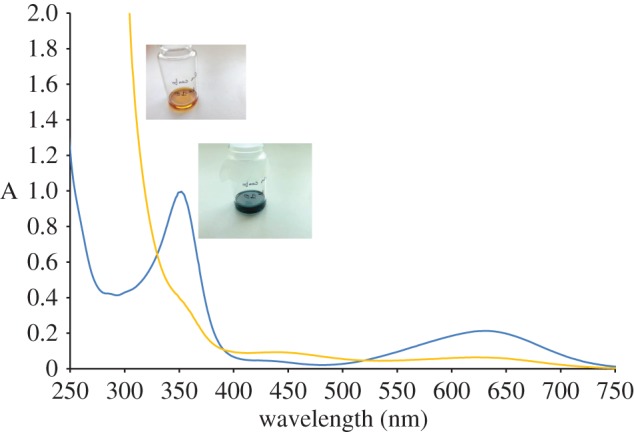
UV–visible spectra of complexes 2 and [2-NO] in acetone (10−4 M, 298 K), and pictures of the corresponding solutions.